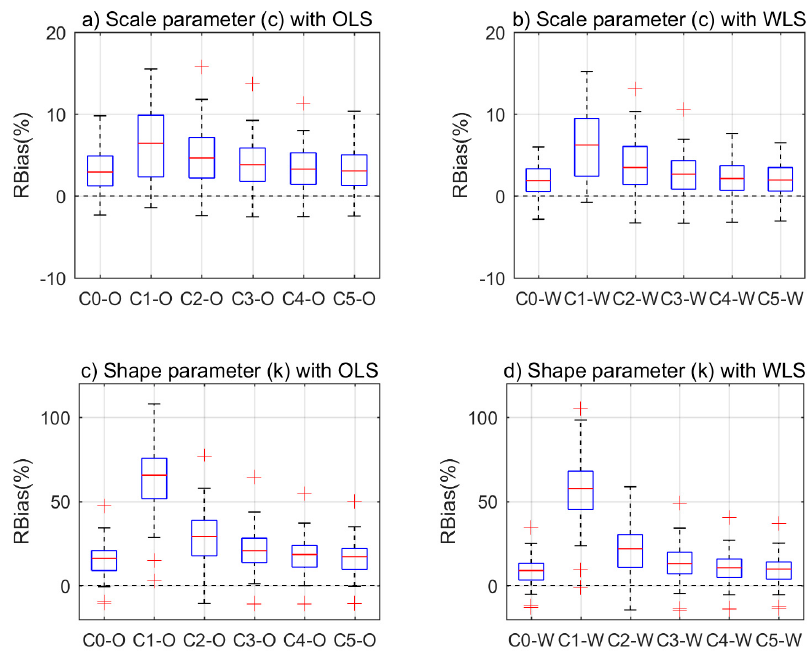
Figure 6. Boxplots of the RBias(%) of scale (c) and shape (k) parameters of the downscaled Weibull distribution with the OLS and WLS methods based on the parameter estimates from the observed Weibull distribution. Note that ( a – d ) presents boxplots of scale parameter estimates with OLS, scale parameter estiamtes with WLS, shape parameter estimates with OLS, and shape parameter with WLS, respectively.